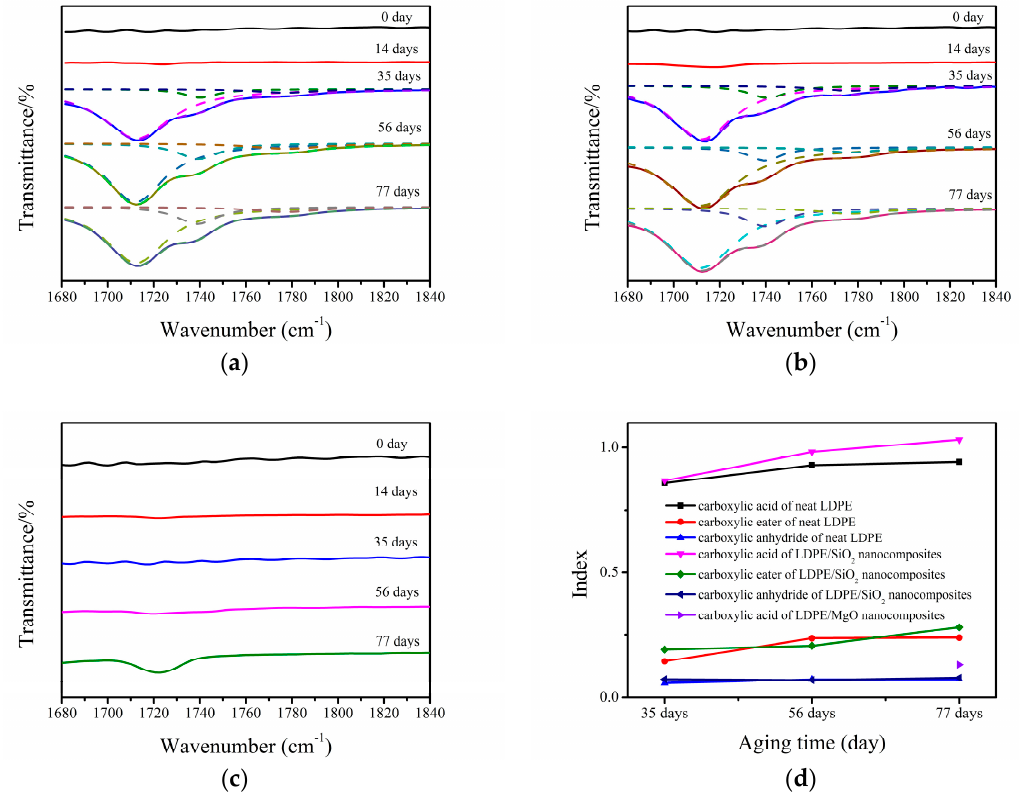
Figure 2. Fourier transform infrared spectroscopy (FTIR) spectra and carbonyl index of neat LDPE and 1 wt %-nanocomposites ( a ) FTIR spectra of neat LDPE, the dashed lines represent the fitting results; ( b ) FTIR spectra of LDPE/SiO 2 nanocomposites, the dashed lines represent the fitting results; ( c ) FTIR spectra of LDPE/MgO nanocomposites; ( d ) Carbonyl index of all samples.